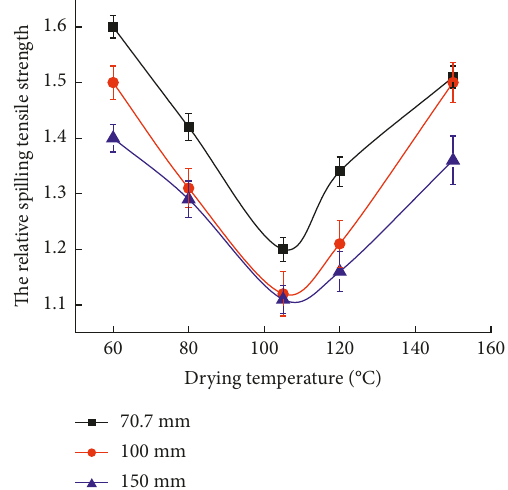
Figure 3: The relative splitting tensile